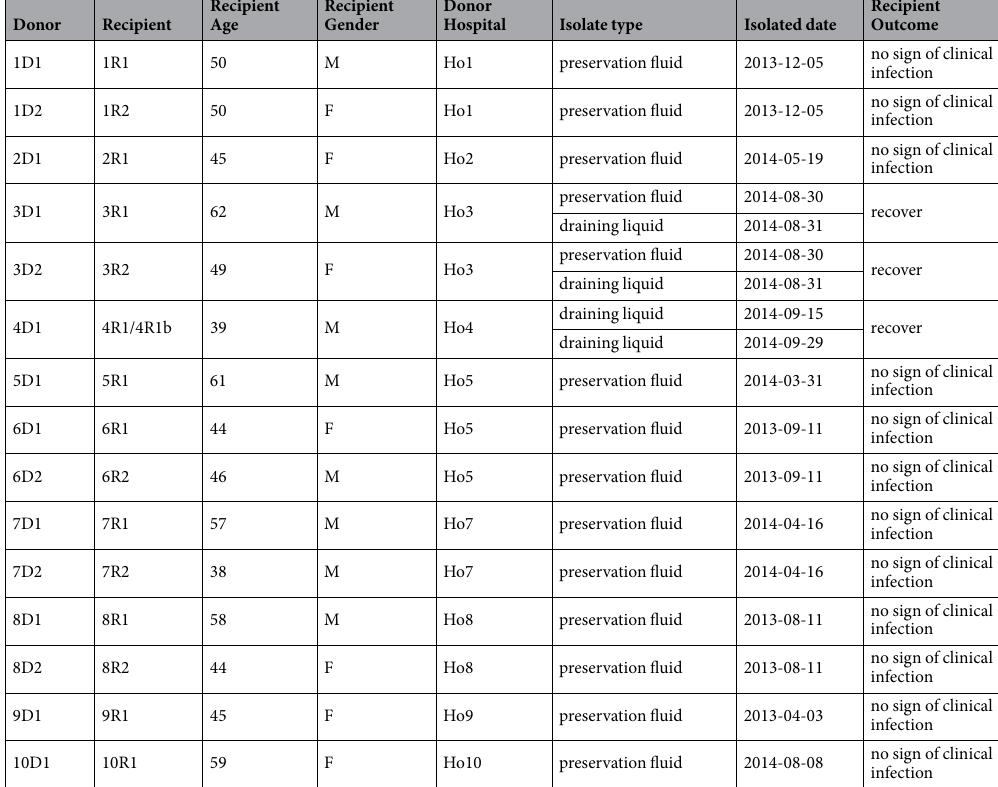
Table 1. Clinical information of matched donors and